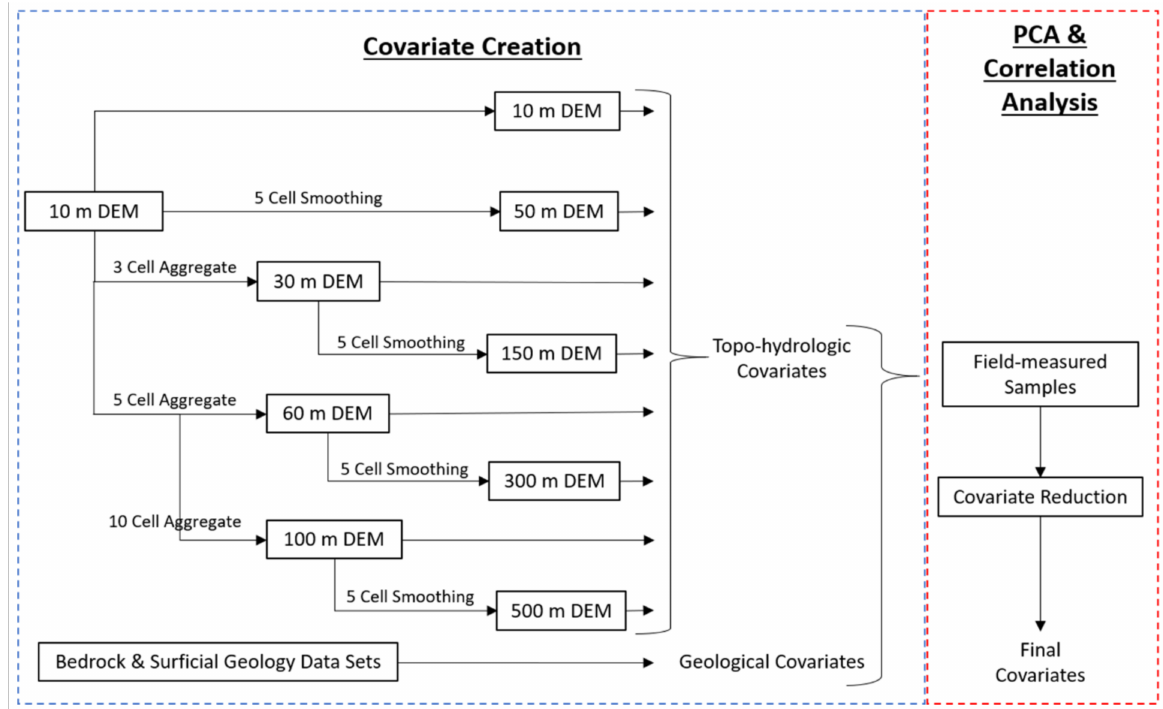
Figure 4. The framework for developing the DTB model covariates. The multi-scale generation of covariates beginning with the 10 m DEM is shown as an example (blue frame) and the correlation analyses that followed to reduce the number of covariates (red